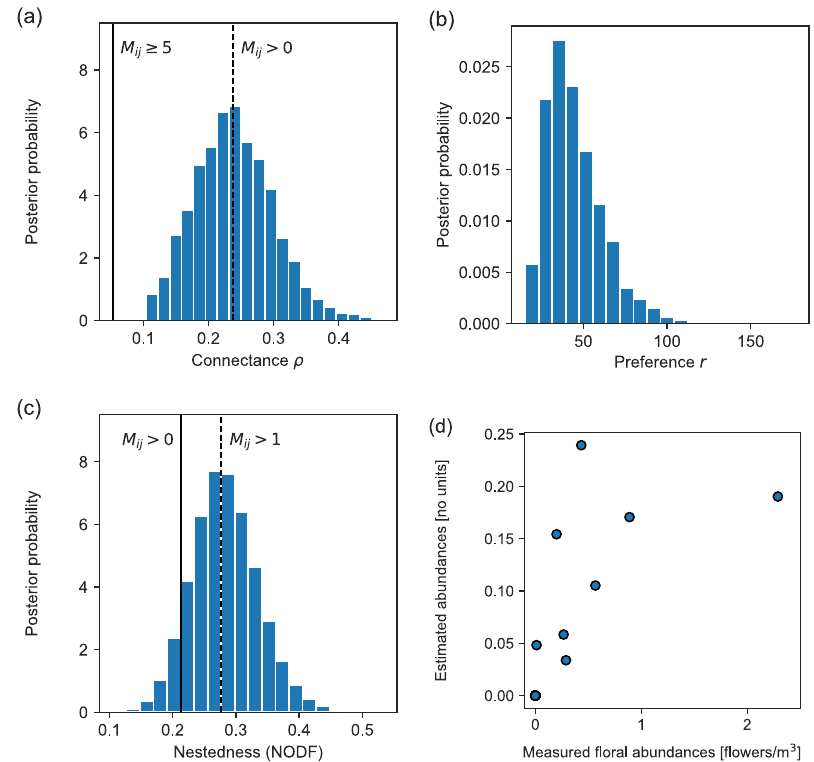
Fig. 3 Analyses that can be performed using samples from the posterior distribution of Eq. (5). a Distribution of the connectance ρ . Connectance values for binary networks obtained by thresholding the data matrix at M ij > 0 and M ij ≥ 5 are shown as vertical lines for reference. b Distribution of the preference parameter r . The mean value of r is 〈 r 〉 = 45.9 and its mode close to 40, but individual values as high as 100 are possible. c Distribution of the nestedness measure NODF. Values obtained by thresholding the data matrix at M ij > 0 and M ij > 1 are shown for reference. d Measured and estimated abundances for each of the plant species ( R 2 = 0.54).